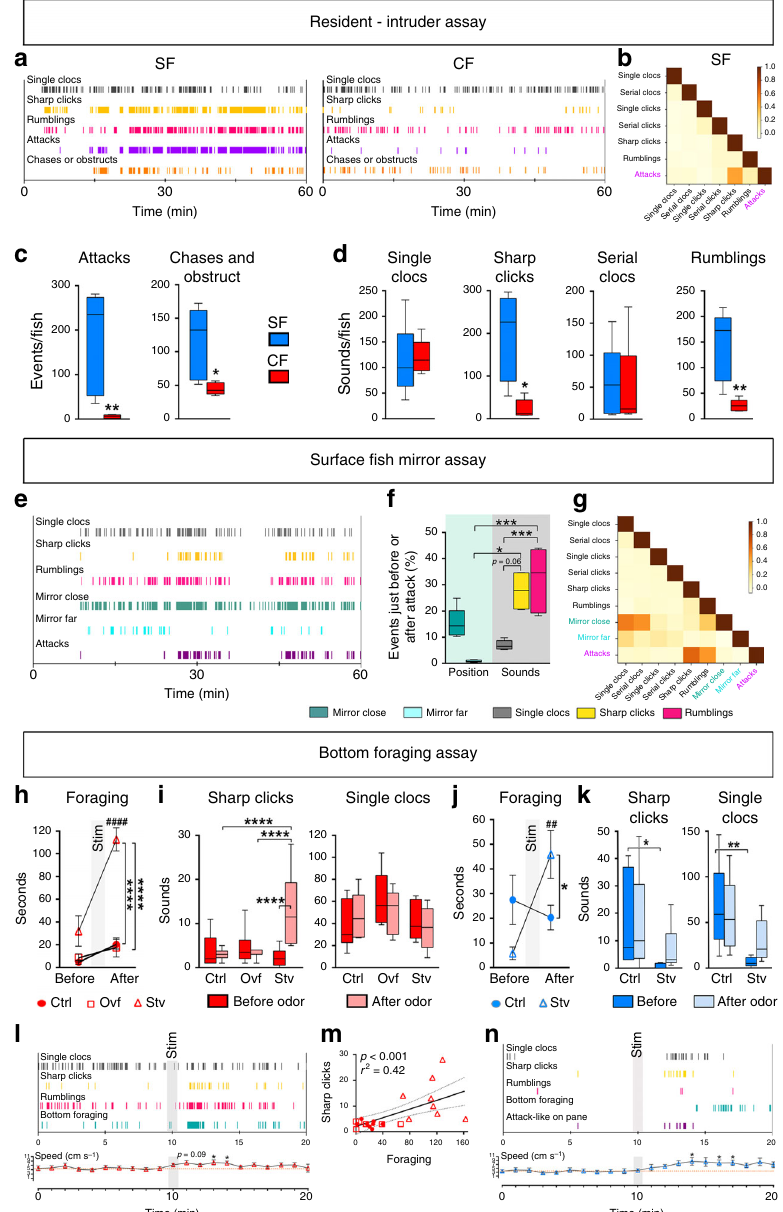
Fig. 4 Comparison of Sharp Clicks use and signi fi cance in cave fi sh and surface fi sh. a Representative ethograms for SF and Pachón CF during a one-hour resident-intruder assay. Each vertical bar indicates an event and the color code is indicated. b Heat map showing the correlation for SF between the occurrence of two events at one second bin level throughout the one-hour test (Pearson ’ s coef fi cients are color coded from beige to dark: 0 ≤ r ≥ 1; See also Supplementary Table 2). c , d Comparison of amounts of agonistic behavioral events and sounds produced during a one-hour resident-intruder assay, normalized per fi sh. On each graph, the behavior, the sound type, and the morph (SF in blue, Pachón CF in red) are indicated. Mann – Whitney tests for attacks and chases ( c ), respectively, U = 0 and U = 2, and Sharp Click and Rumbling ( d ), respectively, U = 1 and U = 0 (* p < 0.05, ** p < 0.01). e Representative ethogram of a mirror assay in SF. f Transition frequency analysis showing the events that just preceded or just followed an attack, in percent, throughout the one-hour test, showing the most frequent associations and sequences of events. Kruskal – Wallis 25.2; p < 0.0001. g Heat map showing the correlation between the occurrence of two events at one second bin level throughout the one-hour test (Pearson ’ s coef fi cients are color coded from beige to dark: 0 ≤ r ≥ 1; See also Supplementary Table 3). h – k , Comparison of amounts of foraging events and sounds produced by fi sh in the 10 min before and after perfusion of an odorant food solution. Pachón CF in red, Surface fi sh in blue. Ctrl, control; Ovf, overfed; Stv, starved. Two-way ANOVA-RM, interactions: F (2,28) = 11.20; p = 0.0003 ( h ), F (2,21) = 13.32 ( i , Sharp Clicks), F (1,16) = 12.42; p = 0.003 ( j ), F (1,16) = 2 . 01; p = 0.176 ( k , Sharp Clicks) , F (1,16) = 2.5; p = 0.13 ( k , Single Clocs). Dunn ’ s posthoc : * p < 0.05, ** p < 0.01, **** p < 0.0001 inter-diet conditions and ## p < 0.01, ### p < 0.001 within diet condition in foraging. l , n Representative ethograms of a starved CF ( l ) and a starved SF ( n ) and respective speed variations of all tested individuals (Friedman p = 0.03, * p < 0.05; Dunn ’ s posthoc p < 0.05 calculated from baseline during 10 min) during foraging assay. The grey shading indicates the period of odor perfusion. m Linear regression showing the relationship between sound production and time spent in bottom foraging behavior in CF (F = 15.65). Data are mean ± SEM. See also Supplementary Data 3 for exhaustive statistics. Source data are provided as a Source Data fi